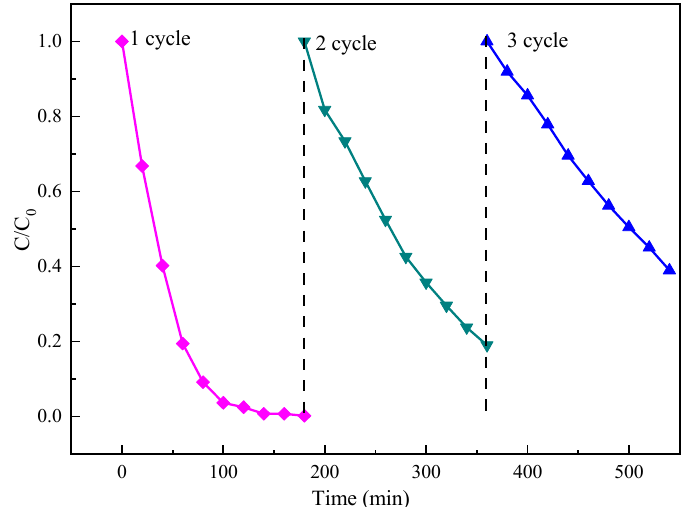
Figure 10. Cyclic photocatalysis of MB under visible light.